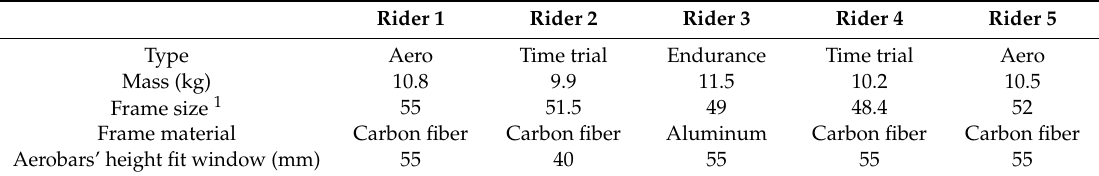
Table 2. Characteristics of the bicycles used by each rider.